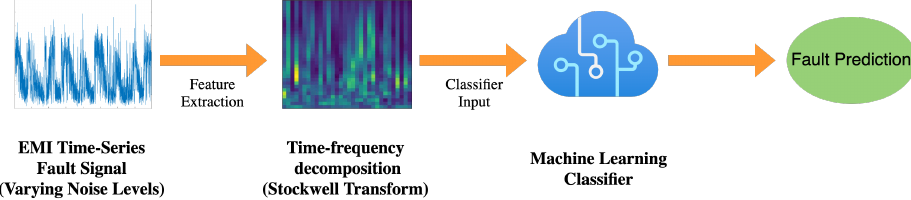
Figure 7. Flow diagram showing the proposed system, outlining feature extraction and classification of EMI signals at varying noise level